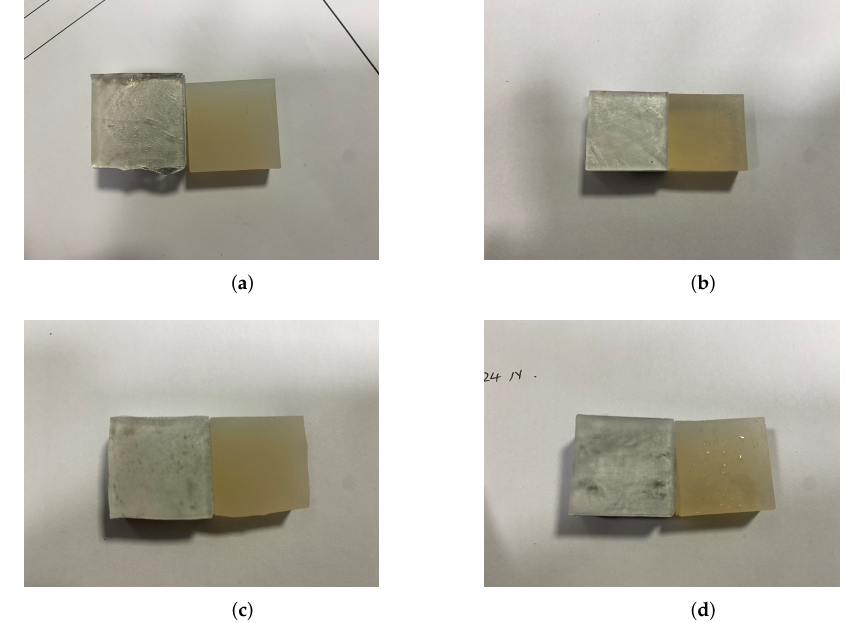
Figure 4. Section view of tensile shear disruption of AL-Ice-SR specimens. ( a ) Experimental section of specimen frozen (by distilled water) for 2 h at − 55 ◦ C. ( b ) Experimental section of specimen frozen by distilled water for 2 h at − 25 ◦ C. ( c ) Experimental section of specimen frozen by lake water for 2 h at − 25 ◦ C. ( d ) Experimental section of specimen frozen by sea water for 2 h at − 25 ◦